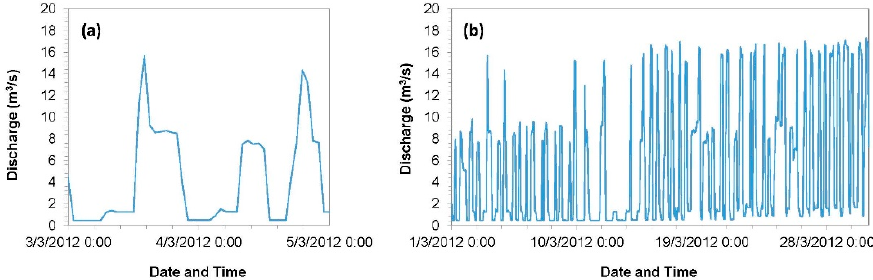
Figure 2. Detail of typical hydropeaks ( a ) in the Noguera Pallaresa study reach and ( b ) the related general hydropeaked regime.